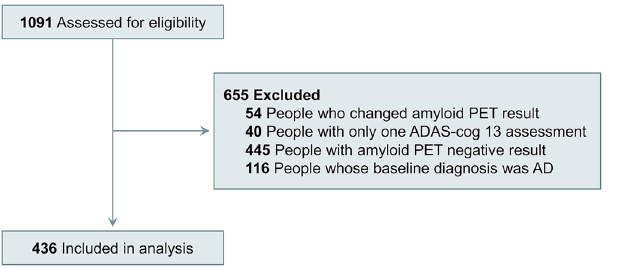
Figure 1. Flow diagram for selection of the study participants. We excluded the following participants: (1) 54 participants whose amyloid PET result changed from positive to negative; (2) 40 participants in whom ADAS-cog13 scores were obtained only once; (3) 445 participants with amyloid-negative PET results, because if amyloid-negative CN could become amyloid-positive, it would be difficult to create a disease progression model with amyloid-negative MCI; and (4) 116 participants with dementia at baseline, because their follow-up was short and the ADAS-cog 13 scores of AD dementia participants were in the range of the ADAS-cog 13 scores of participants who progressed from MCI due to AD to AD dementia. ADAS-cog: Alzheimer’s Disease Assessment Scale-cognitive subscale, CN: cognitive normal; MCI: mild cognitive impairment; AD: Alzheimer’s